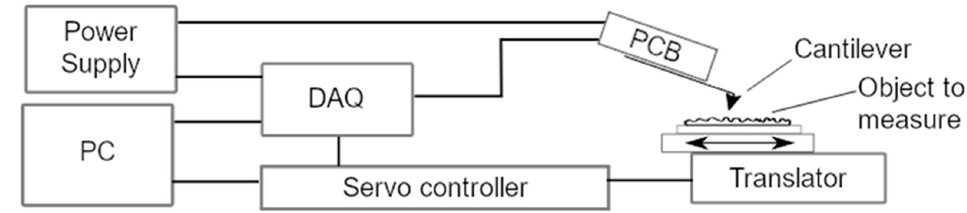
Figure 2. Schematic representation of the measurement setup. The translator, based on a piezoelectric drive, functions as a datum for the profile measurement and is controlled by the servo controller. A different software (PIMikroMove 2.29.8.1) controlled the movement of the transla-